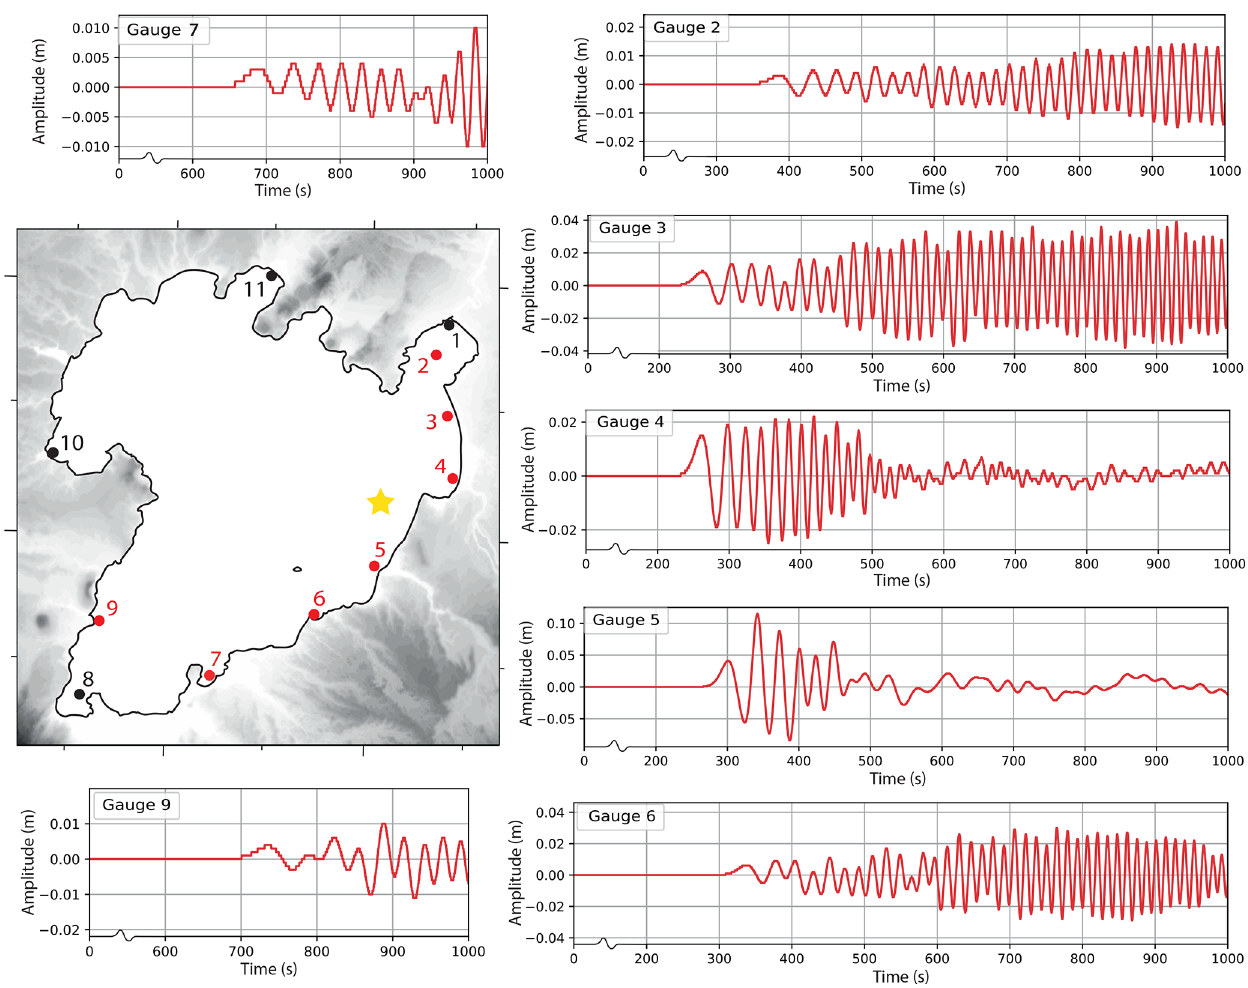
Figure 11. Time series for numerical gauges with gauge locations highlighted in red on inset map including ground zero signified by the star. Time series have varying y -axis scales and truncated x